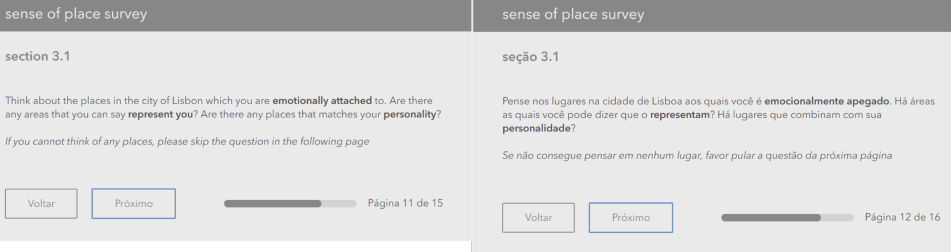
Figure 14: Introduction to place identity section.